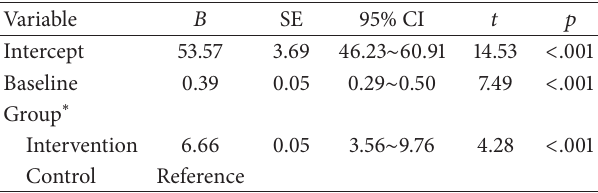
Table 3: Comparative effect of father-child skin-to-skin contact on the father-child attachment